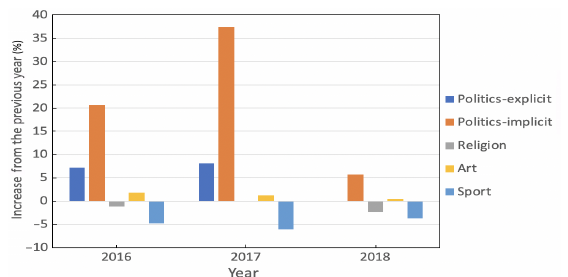
Fig. 4 Growth rate of bio keywords categories, by year— longitudinal sample.